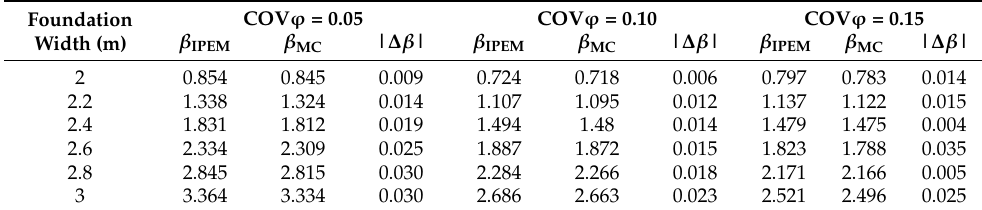
Table 4. The errors of the IPEM method for